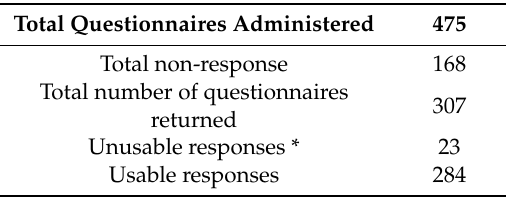
Table 1. Questionnaire response